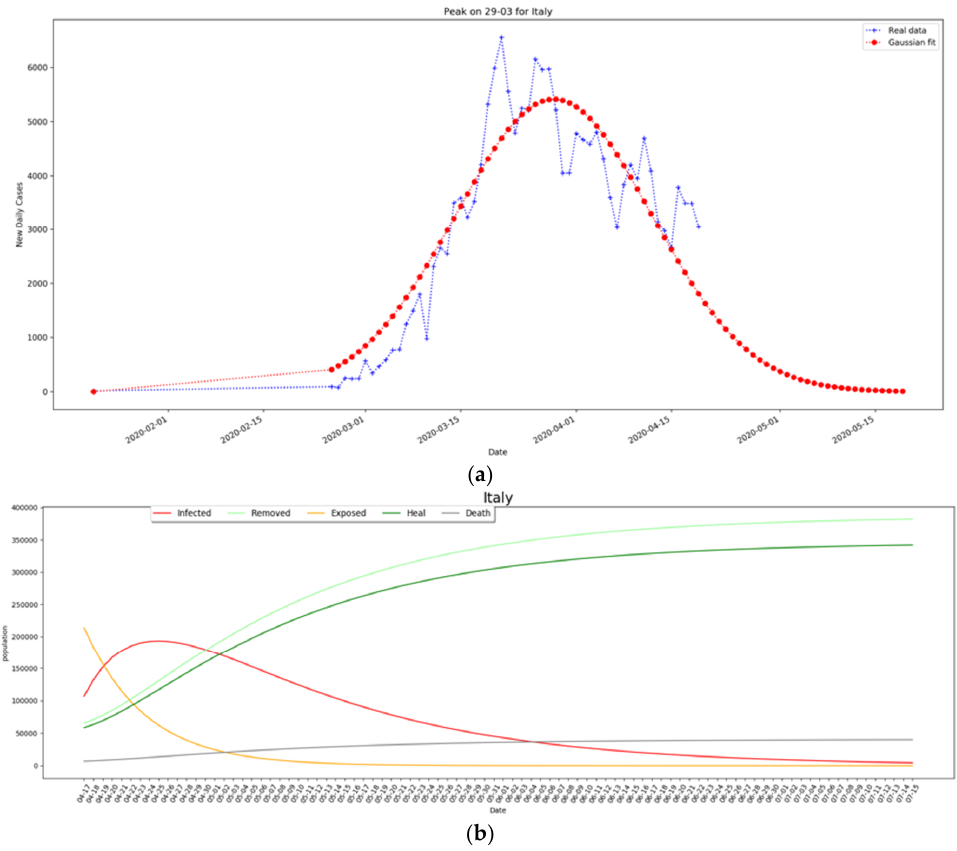
Figure 6. Prediction of the peak for Italy of newly active cases occurred on March 29 th (a), and exposed, infected, and the deceased shown in (b). An estimate of the peak of more than 180,000 active cases is shown to occur on the second half of April.